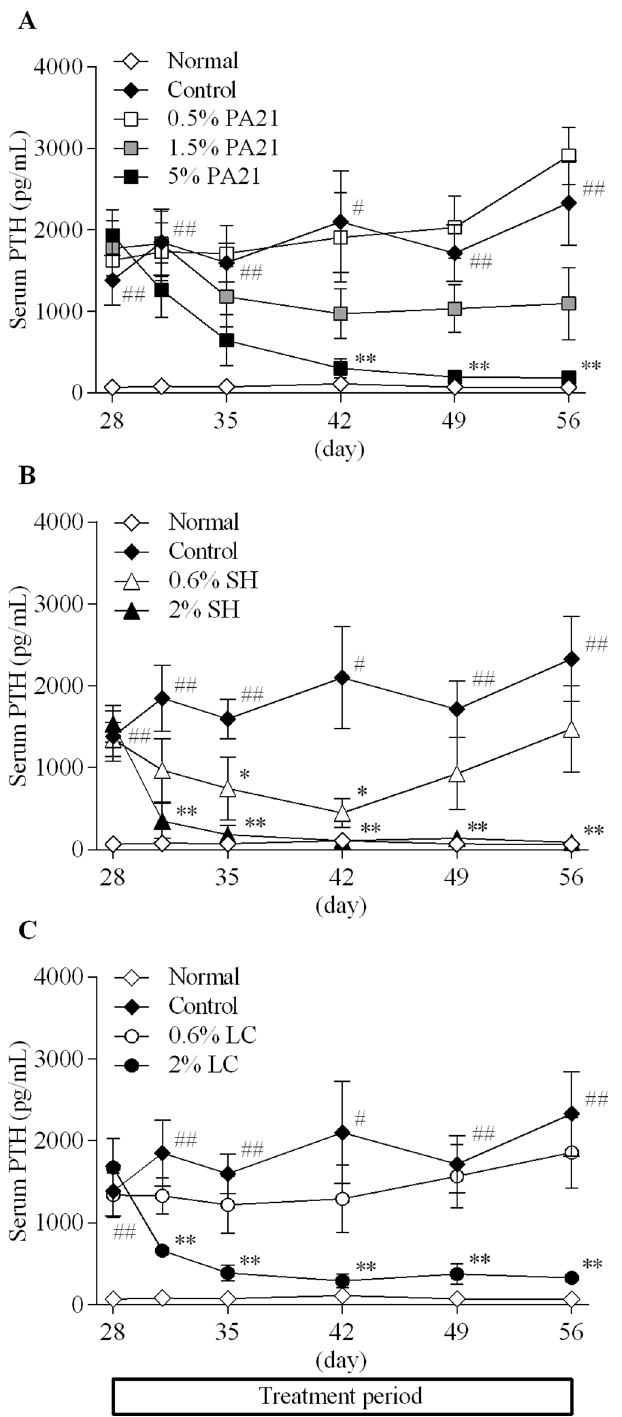
Fig 4. The effects of (A) PA21, (B) sevelamer hydrochloride, and (C) lanthanum carbonate hydrate on serum PTH level. Each dot in the figures shows the mean value ± standard error of eight to 10 animals. SH, sevelamer hydrochloride; LC, lanthanumcarbonatehydrate. # P < 0.05 and ## P < 0.01, Aspin-Welch’st-test betweenthe normaland control groups. * P < 0.05 and ** P < 0.01, Dunnett’s or Steel’s multiplecomparison tests betweenthe control and the investigateddrug administered